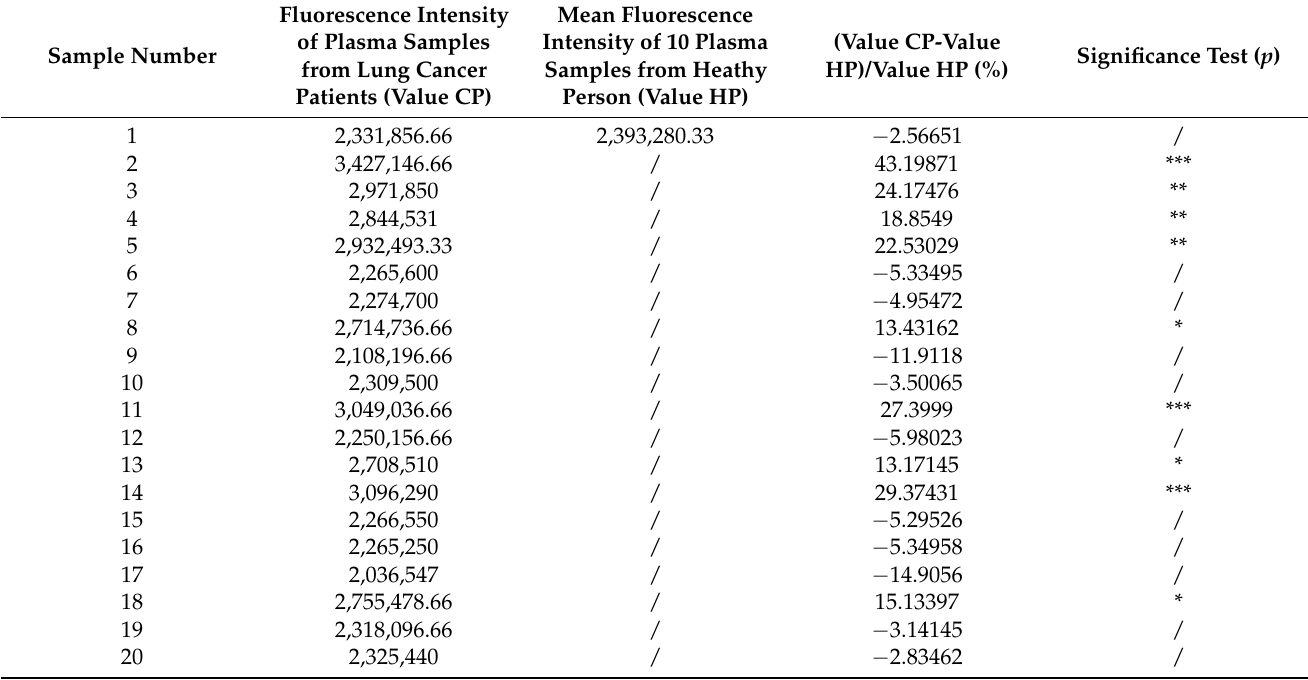
Table 2. The detection results of EGFR exon 19 mutations from the clinical samples.